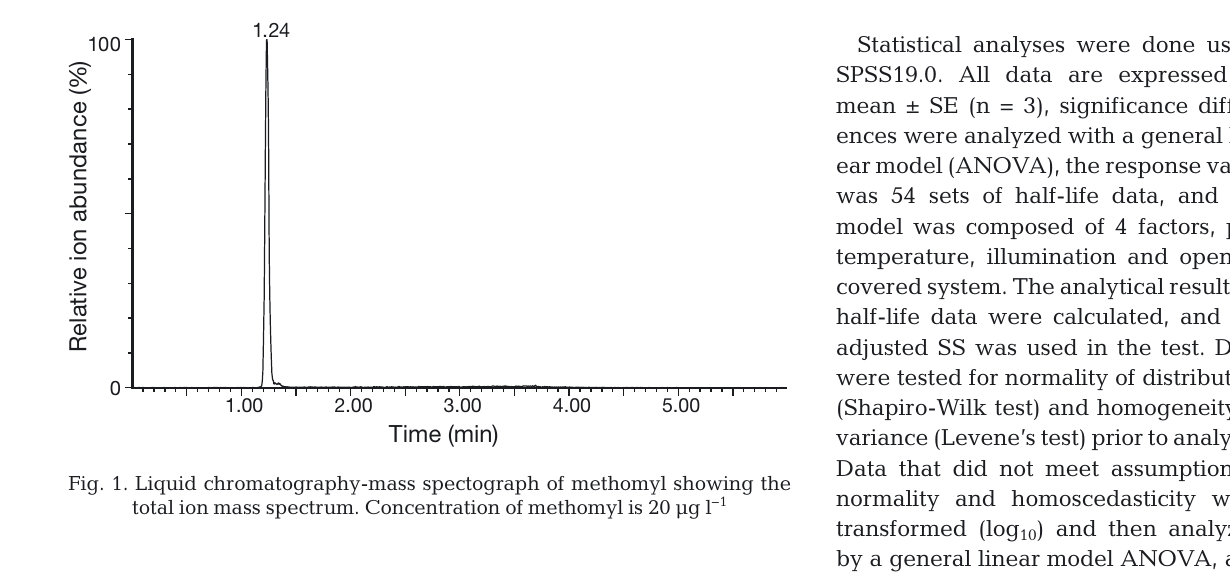
blank sample was run both before and after the treat- ment, the standard recovery range was 78.3−115.3%.